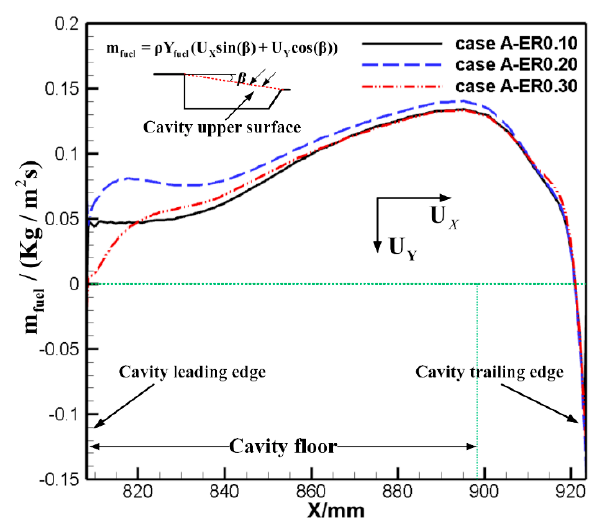
Figure 14. Comparison of the fuel entrainment rate across the cavity upper surface in injection scheme A cases (in this study, positive values of m fuel indicate that the fuel flows into the cavity).